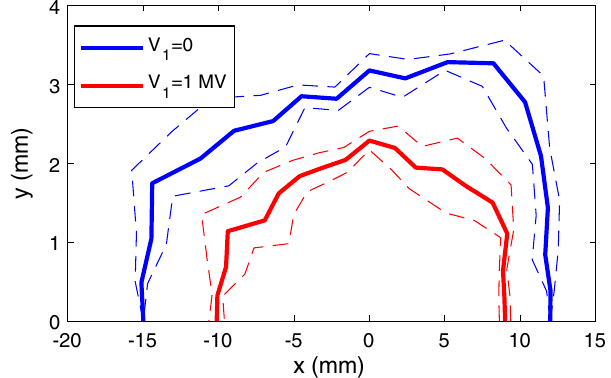
FIG. 4. Comparison of the storage ring dynamic aperture at the septum with two-frequency crab cavities ( V 1 ¼ 1 MV) and without crab cavities. A vertical physical aperture of 3.5 mm is in the lattice model. The solid lines are average values of 15 random seeds of linear optics and coupling errors in each case. The dashed lines represent the “ error bars ” calculated with the standard deviations. Dynamic aperture is evaluated by tracking particles for 5000 turns with radiation damping turned